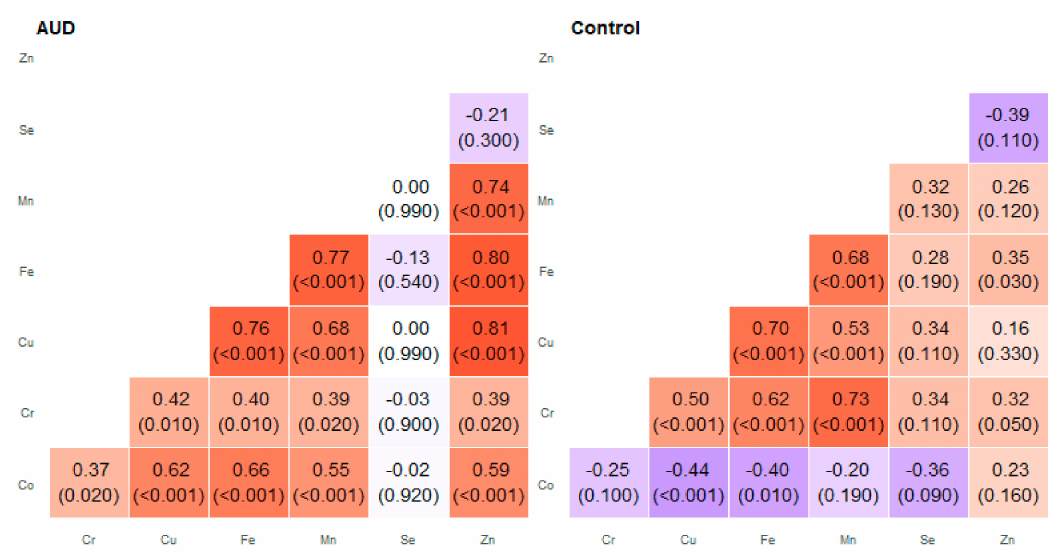
Figure 2. Correlation matrix of Spearman coe ffi cient charts in the anterior cingular cortex region in the alcohol use disorder and control